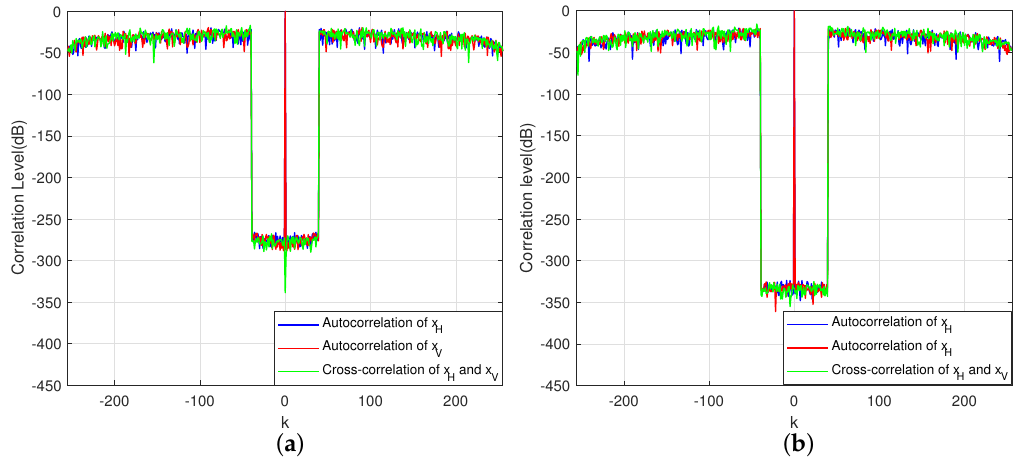
Figure 2. The correlation levels of the WeCAN approach and the IAG approach. ( a ) WeCAN; ( b )